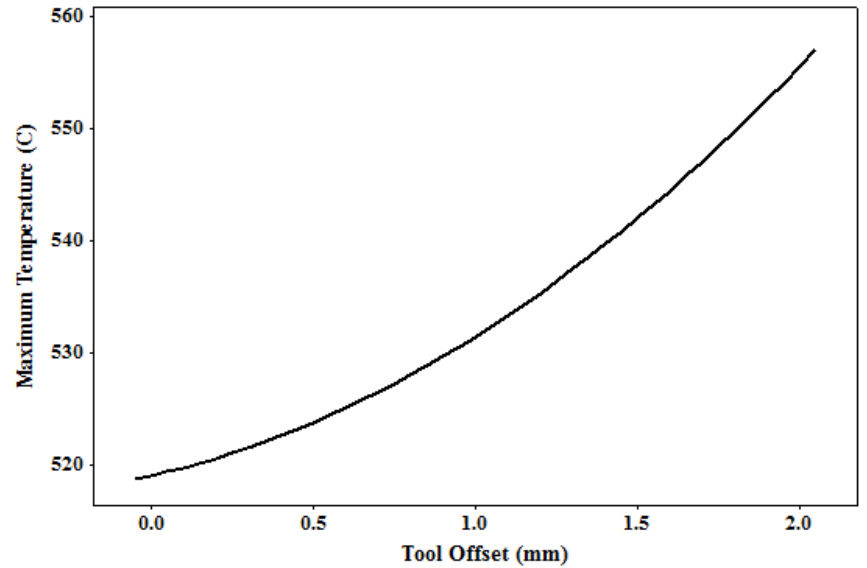
Figure 10. Maximum temperature vs. tool offset for welded samples.